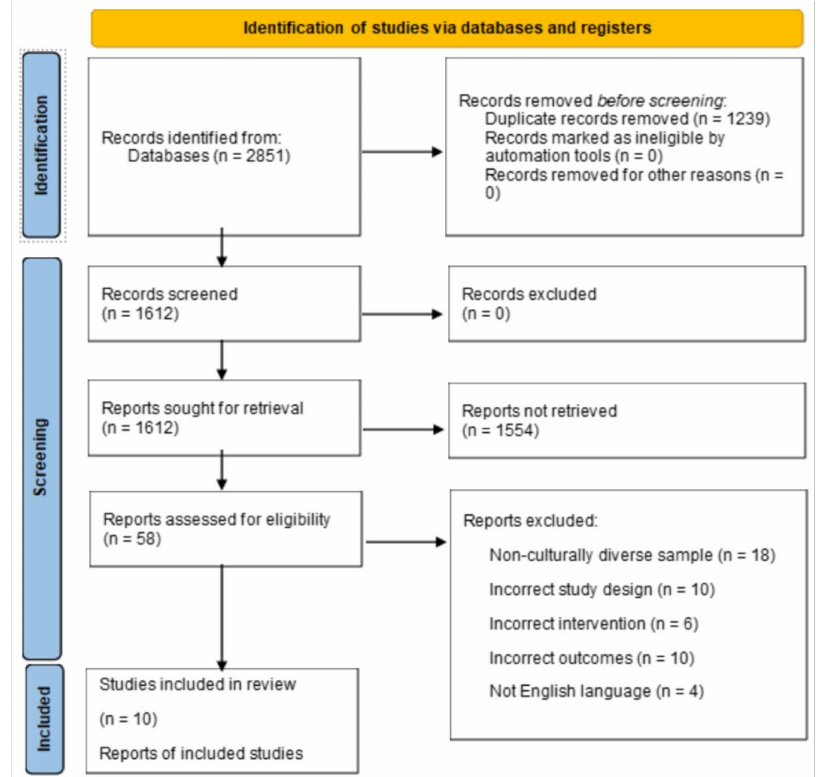
Figure 1. Preferred Reporting Items for Systematic Reviews and Meta-Analyses (PRISMA) flow diagram for study selection. Adapted from Page et al. (2021)